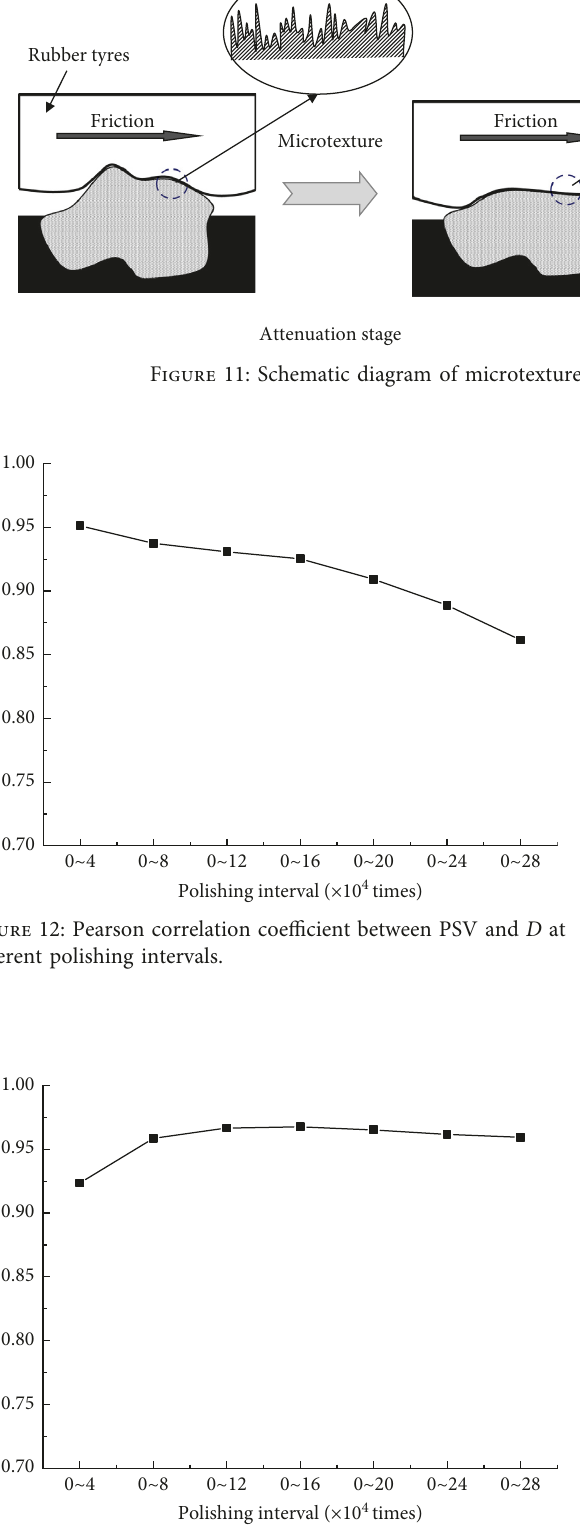
Figure 13: Pearson correlation coefficient between PSV and R q at different polishing intervals.